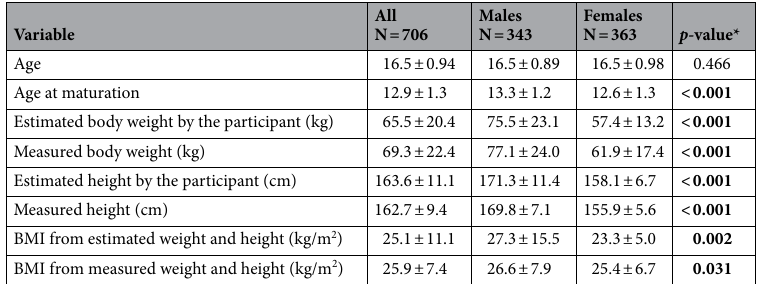
Table 1. Descriptive characteristics of the participants relative to gender. Data are means ± standard deviations or percentage. * T test for independent samples or Chi squares tests for the proportion. Significant values are in